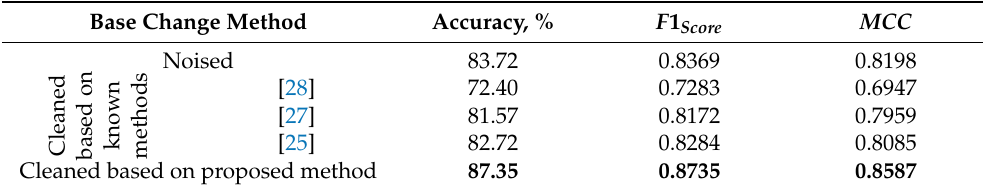
Table 4. Criteria and metrics of recognition accuracy of the CIFAR10 base, previously cleared of 1% random-valued impulse noise.